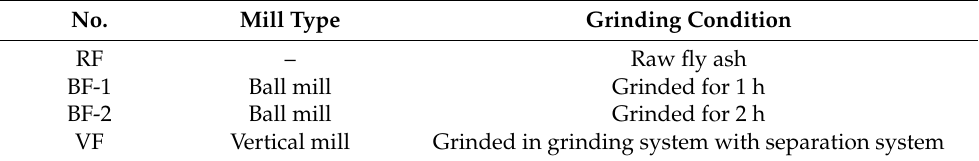
Table 2. Different grinding conditions.